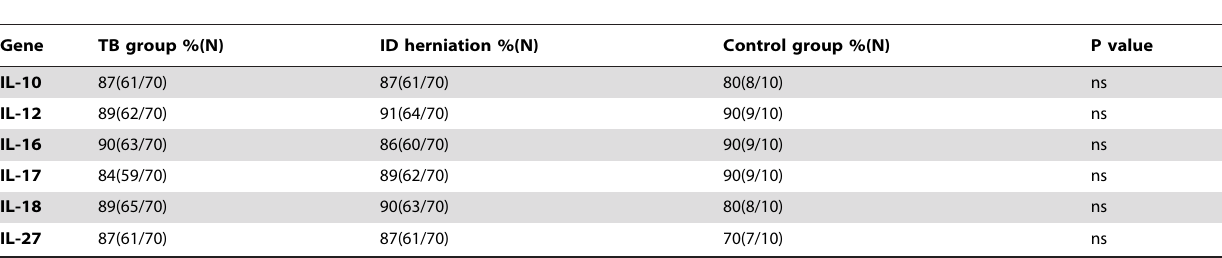
ns=not significant.